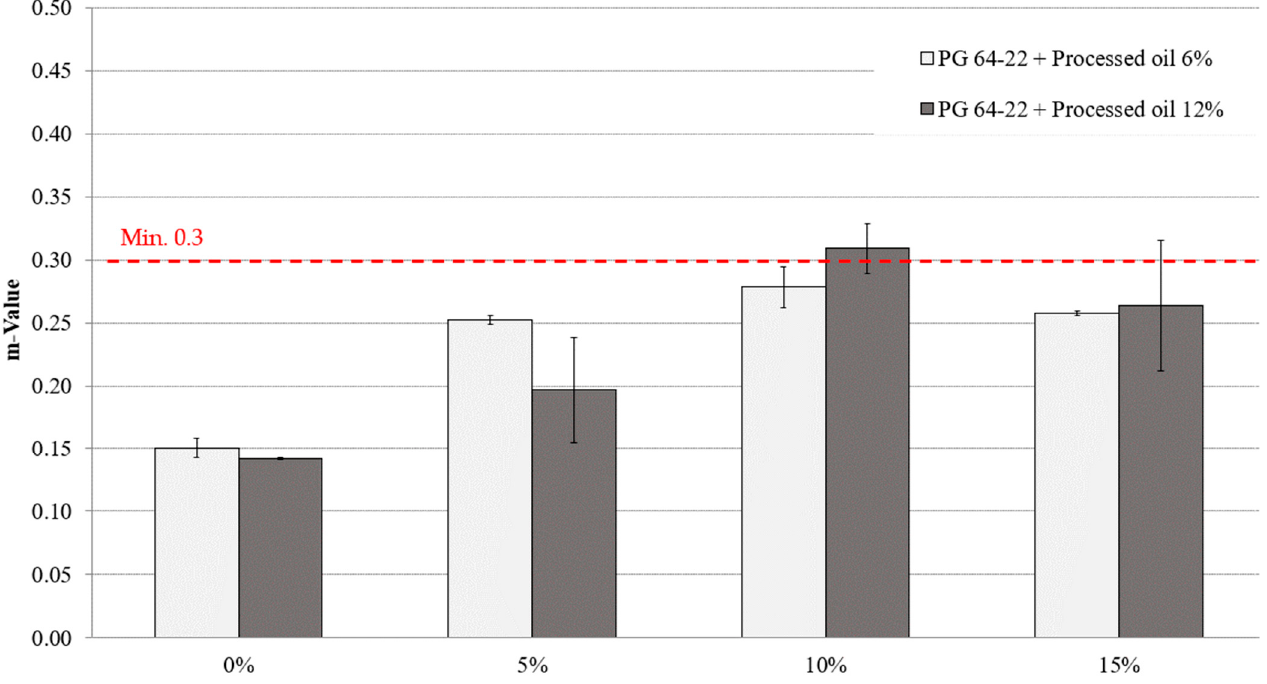
Figure 10. Effect of CRM content on m-value of processed oil-modified and long-term aged PG 64-22 binder aged at − 24 °C.